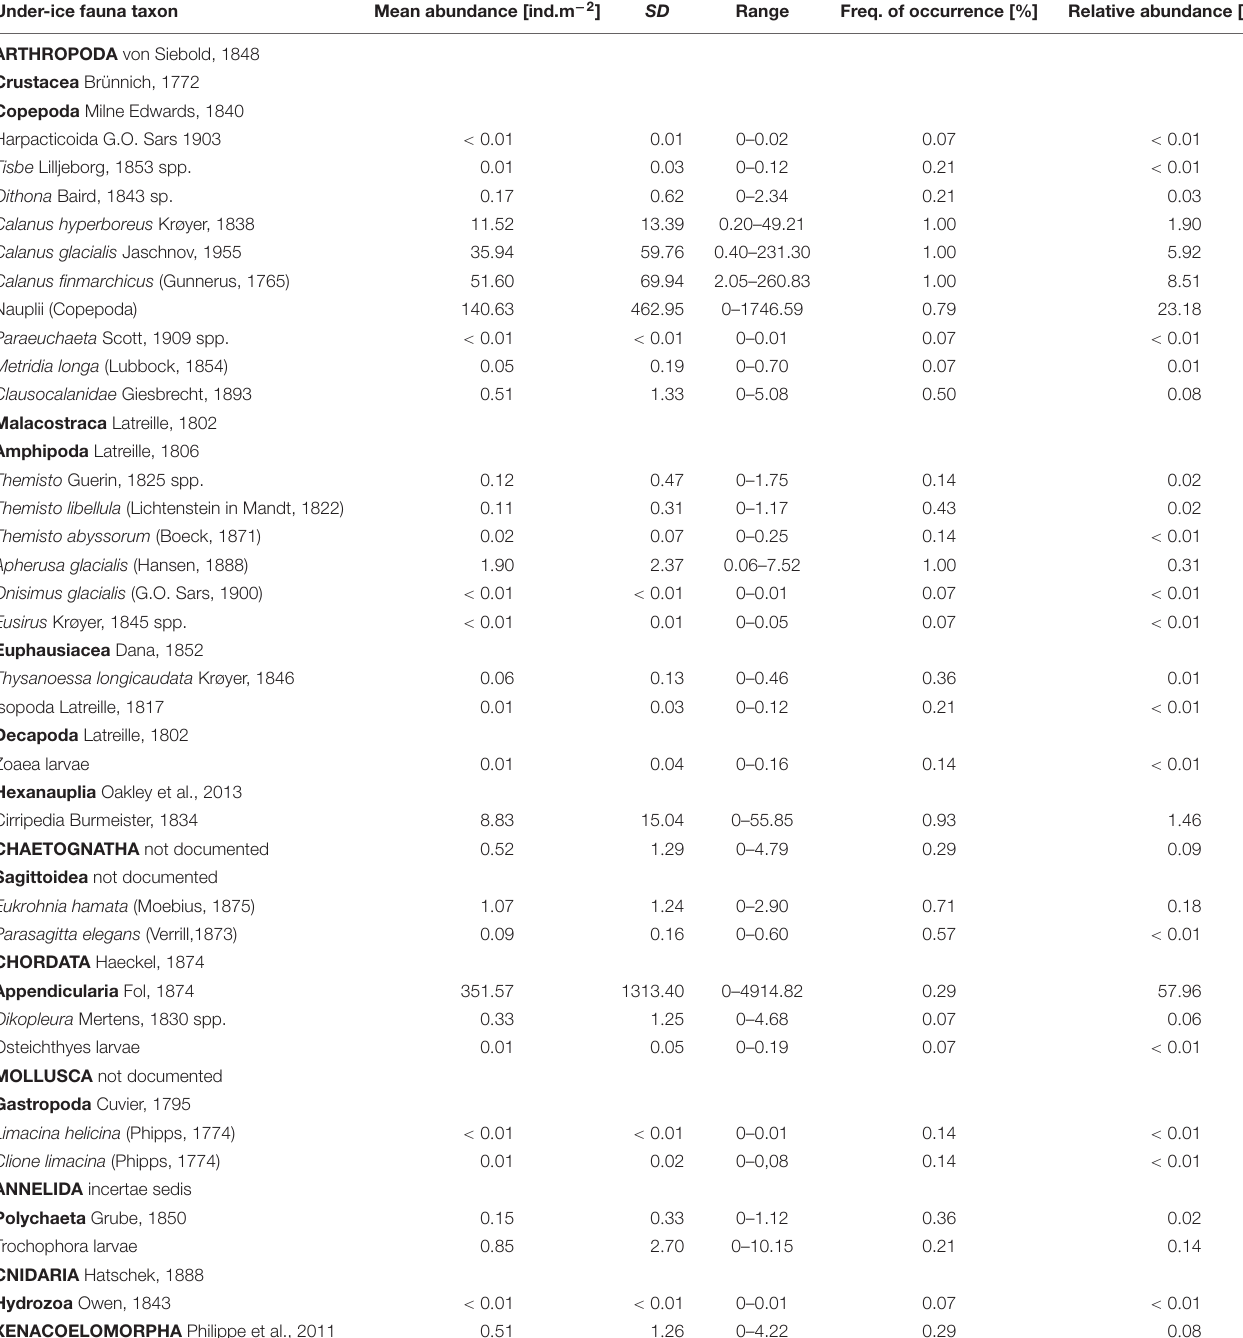
TABLE 6 | List of under-ice fauna with mean abundance and frequency of occurrence across the sample area. Under-ice fauna taxon Mean abundance [ind.m − 2 ] SD Range Freq. of occurrence [%] Relative abundance